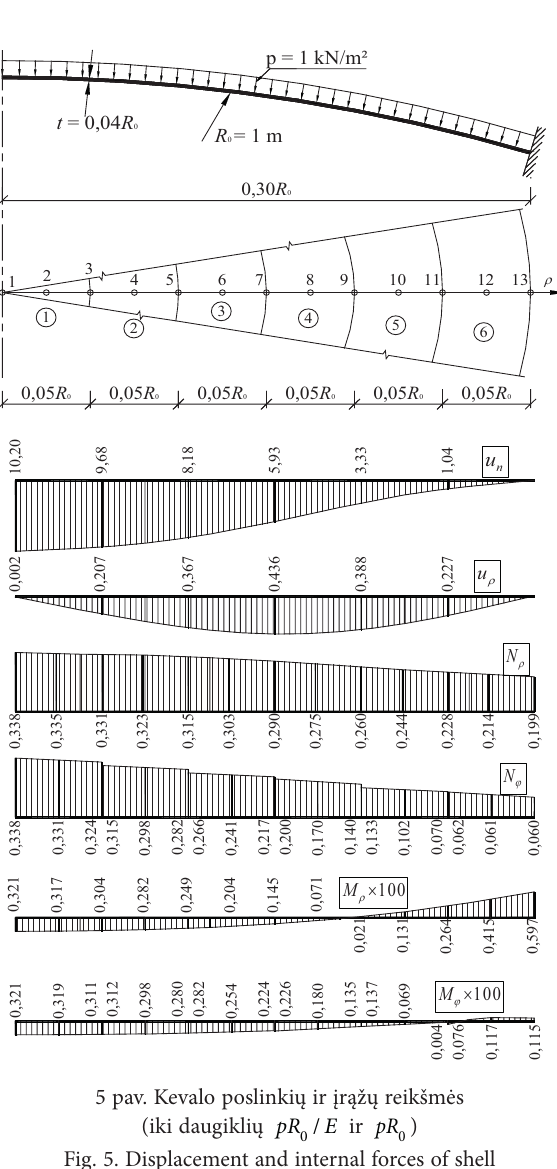
5 pav. Kevalo poslinkių ir įrąžų reikšmės (iki daugiklių Fig. 5. Displacement and internal forces of shell (up to the factors